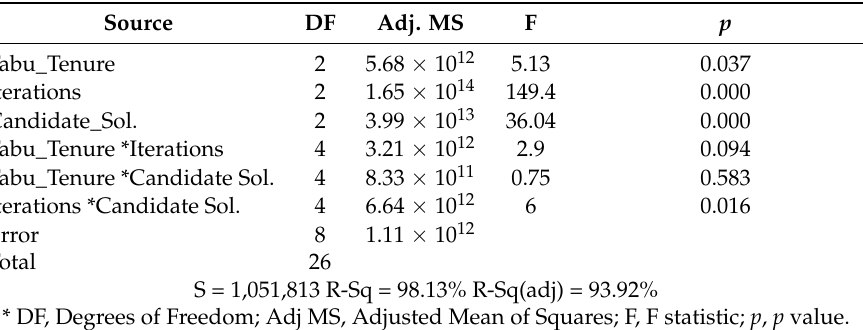
Table 6. ANOVA for total planning cost in small problems.